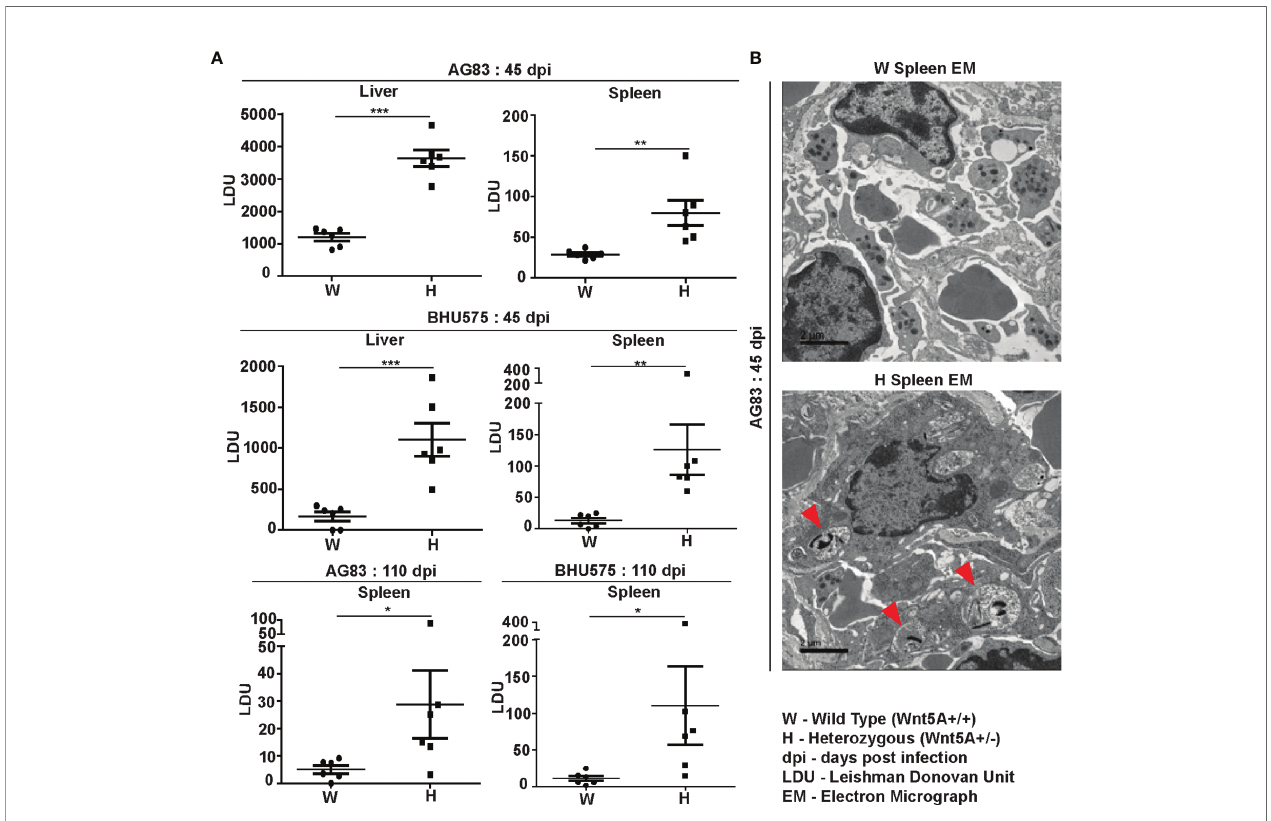
FIGURE 1 | Evaluation of L. donovani infection in the liver and spleen of Wnt5A+/+ wild type (W) and Wnt5A+/- heterozygous (H) mice. (A) Microscopic examination of imprints of liver and spleen from infected mice reveals signi fi cantly higher parasite load as measured by Leishman Donovan Unit (LDU) in the H category of mice than the control W category, both 45 days and 110 days post infection (dpi) with either the AG83 or BHU575 strain of L. donovani . (B) TEM micrographs showing parasitophorous vacuoles (PV) in a spleen section of H but not W category after infection. PV was more frequent in H than in W. Data are presented as mean ± SEM. Statistical analysis was performed with the unpaired t-test. Signi fi cance was annotated as follows: * p ≤ 0.05, ** p ≤ 0.005, *** p ≤ 0.0005, n=6 (per group). EM representation is based on evaluation of at least 10 different fi